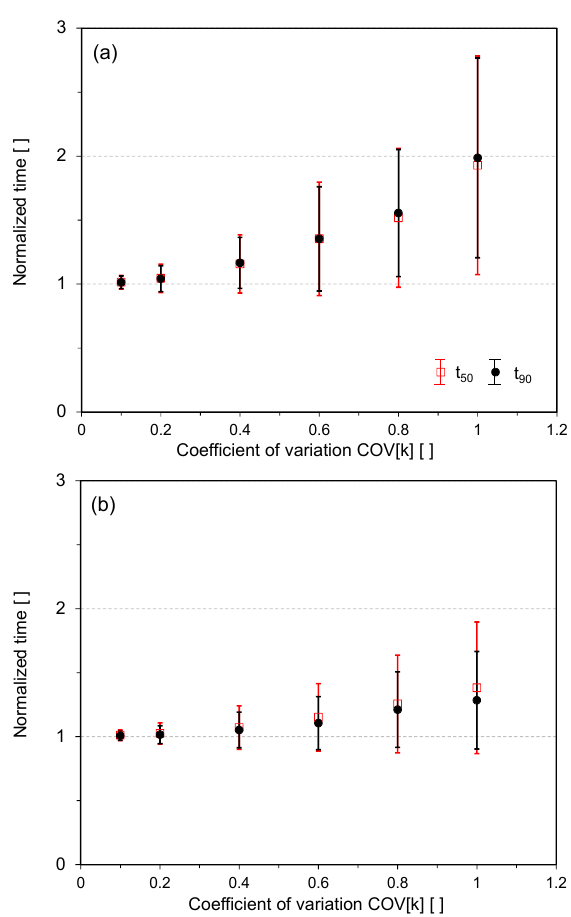
Figure 7. Effect of spatially varying hydraulic conductivity COV[k] on consolidation times t 50 and t 90 of heterogeneous soils with different drainage conditions; ( a ) No vertical drainage; ( b ) Vertical drainage. In all cases, dimensionless correlation length is kept constant Θ = 0.1.